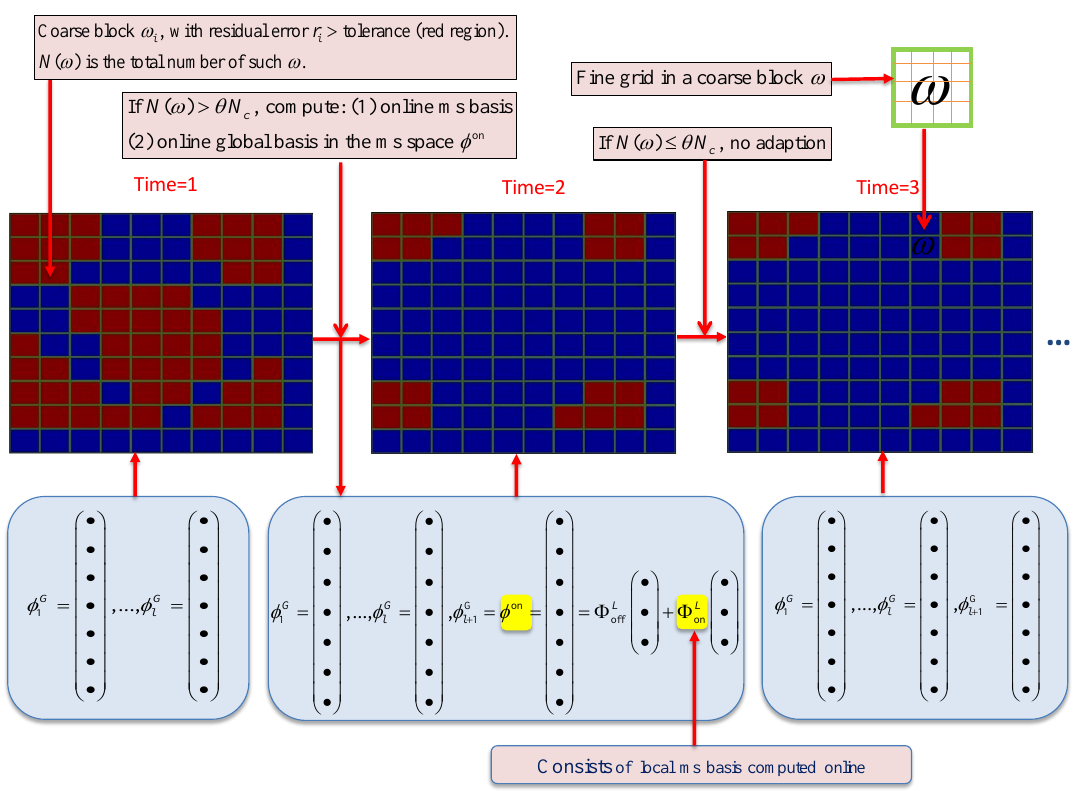
Figure 3. Schematic description of the online adaptive local-global POD